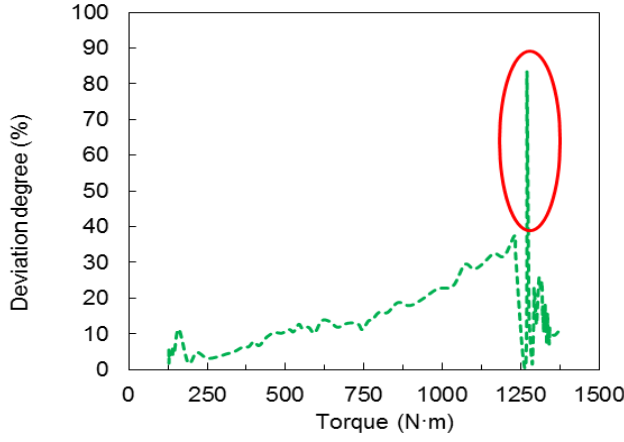
Figure 8. E ff ect of close loop control strategy on transient performance: ( a ) EGR opening and EGR rate; ( b ) exhaust oxygen concentration; ( c ) NOx; ( d ) smoke opacity; ( e ) Air inflow concentration.